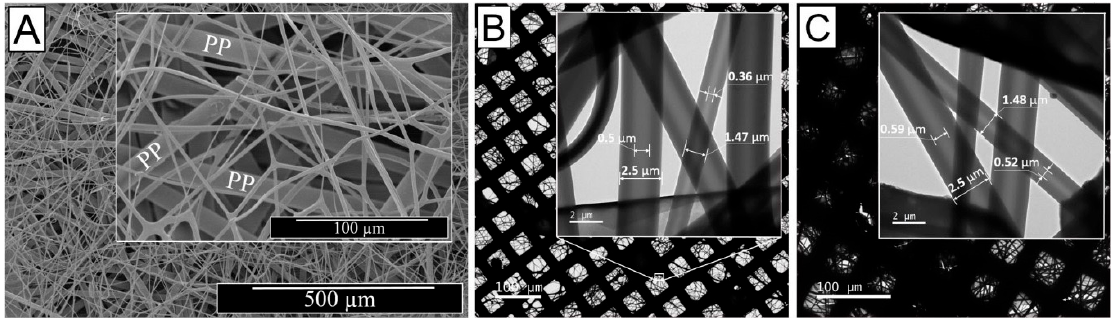
Figure 5. Microscopy images of single ‐ layer membranes of core ‐ shell electrospun fibres. ( A ) SEM image of CS ‐ PAA12 ‐ (PMMA ‐ co ‐ MAA) fibres collected on a PP mesh. ( C , D ): TEM images of samples CS ‐ PAA10 ‐ (PMMA ‐ co ‐ MAA) ( B ) and CS ‐ PAA12 ‐ (PMMA ‐ co ‐ MAA) ( C ) once mounted onto a lacey carbon ‐ coated copper grids. Inset images show individual fibres with core ‐ shell boundaries.